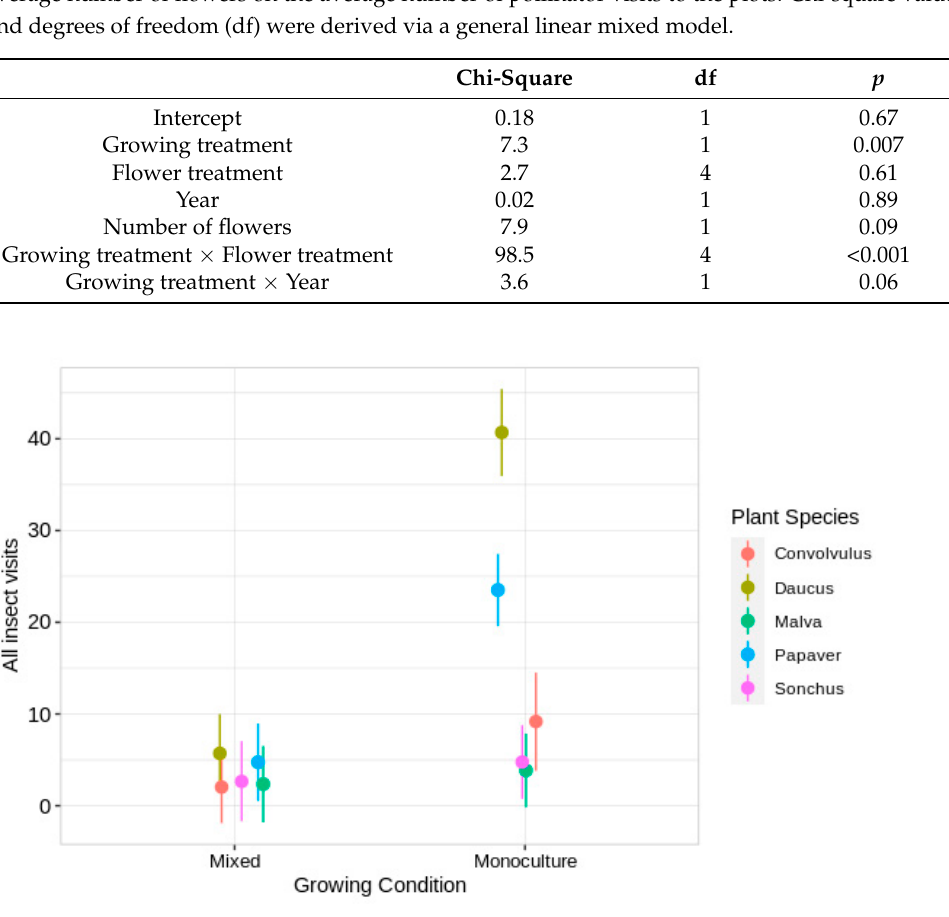
Figure 6. Differences in the average number of insect visits when plants were grown in monocul- tures vs. mixed plots. Values are the estimated marginal means from the general mixed-effects model accounting for the number of flowers in the plots. Bars show confidence intervals at the 0.95 level. Flower species are indicated by genus.